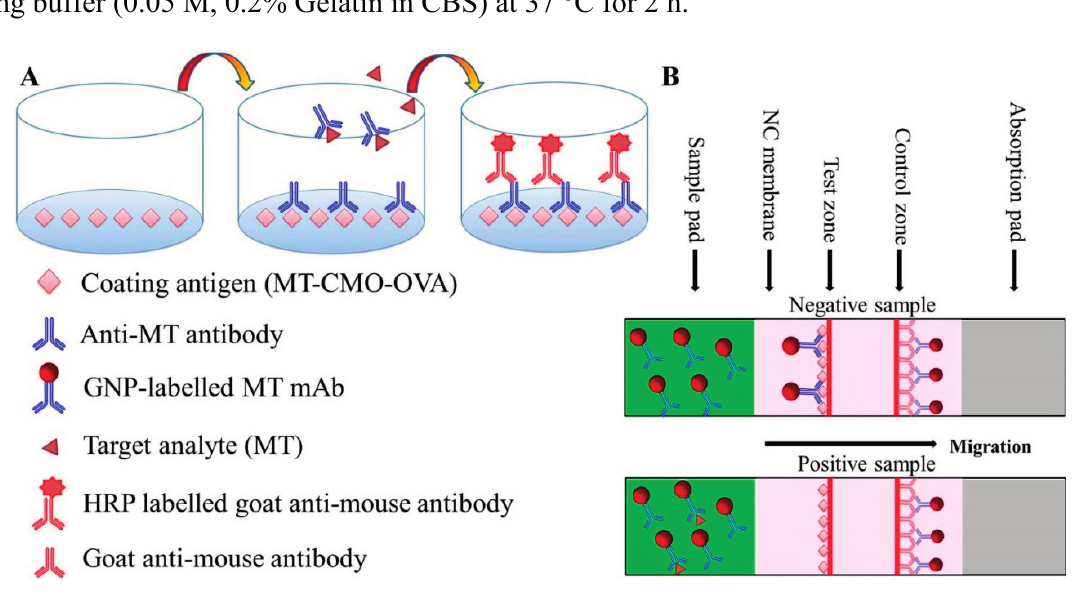
Figure 1. Schemes of icELISA ( A ) and immunochromatographic strip ( B ) for MT detection,